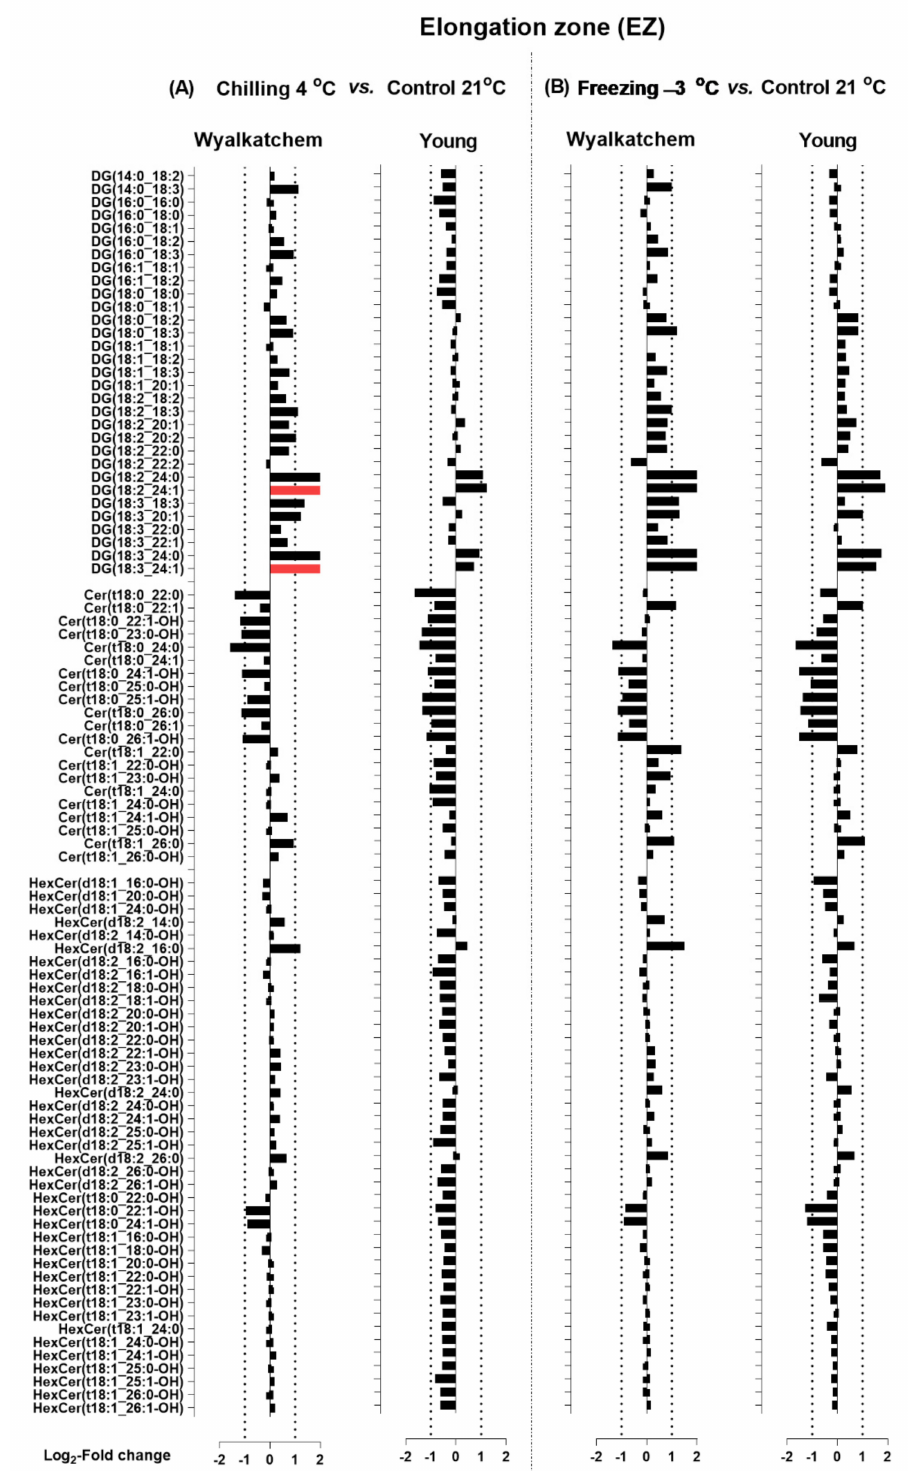
Figure 7. Log 2 -fold changes of DG, Cer and HexCer species in the elongation zone (EZ) of the cold-sensitive Wyalkatchem and cold-tolerant Young after exposed to ( A ) chilling and ( B ) freezing stresses. Statistical significance was determined using an FDR-adjusted p -value of 0.05 as the cut-off. Green bar = significant decrease; Red bar = significant increase. Black bar represents lipid species that has no significant change after cold stress as compared to control. n =